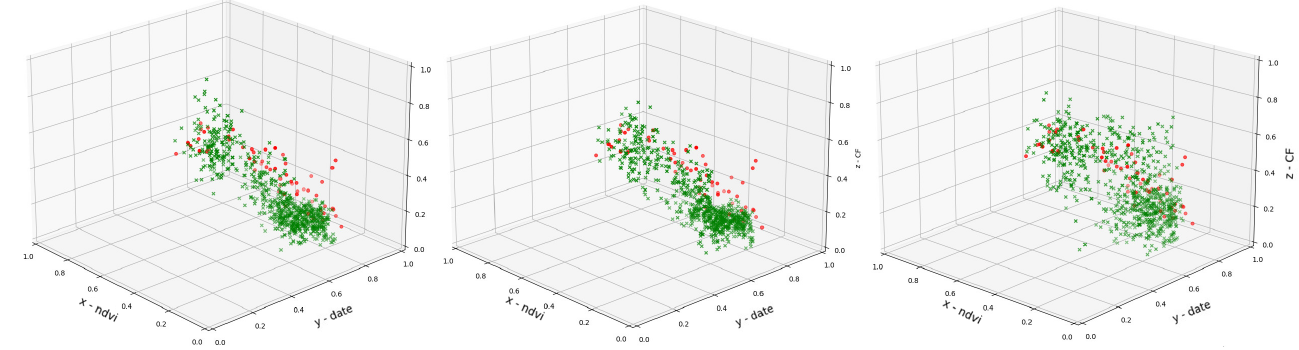
Figure 5. Generated weak labels in green versus ground truth data in red for the GMM ( left ), KNN ( middle ), and KDE ( right ) for Field